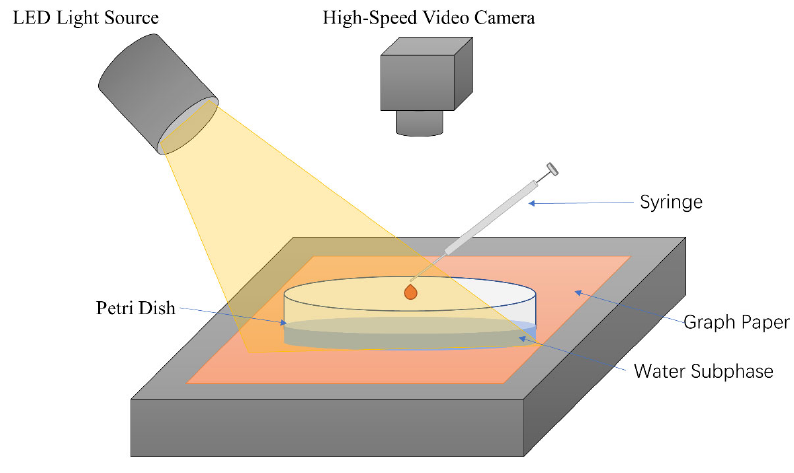
Figure 5. Schematic diagram of the experimental setup.